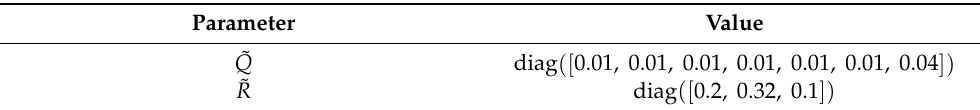
Table 2. LQR weight